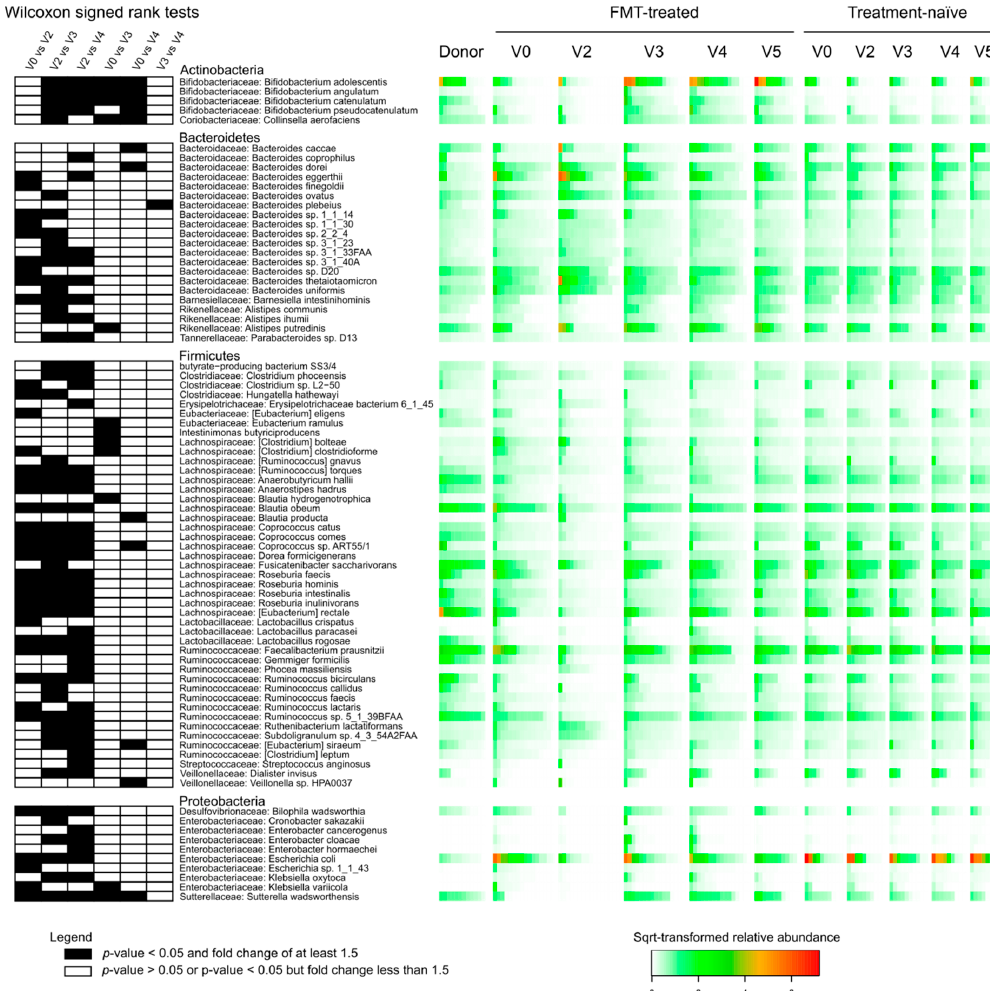
Figure 4. Differentially abundant species in FMT-treated carriers. For each of the 81 represented species, we report the statistical significance (Wilcoxon signed rank test) of changes in the relative abundance between time points (left), phylum and family assignments (middle) and the relative abundance in donor, FMT-treated and treatment-naïve carriers (right). Importantly, we selected species for which at least one of the 6 pairwise comparisons reported (V0 vs. V2, V0 vs. V3, V0 vs. V4, V2 vs. V3, V2 vs. V4, V3 vs. V4) was statistically significant ( p < 0.05) with a ≥ 1.5 fold change in the relative abundance and a mean relative abundance ≥ 0.1% in at least one of the two compared groups. Significant differences ( p < 0.05) associated with a ≥ 1.5 fold change in the relative abundance are represented as black shaded cells; white cells denote other cases. Relative abundances are square-root-transformed and color-scaled as indicated in the legend.